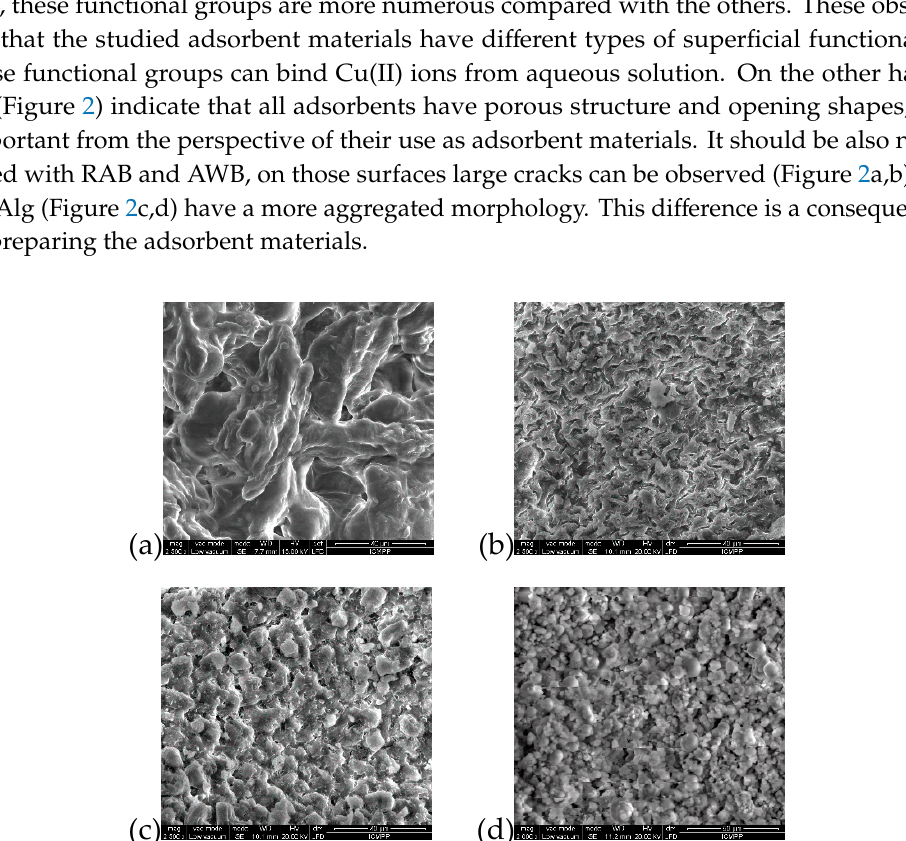
Figure 3. Influence of contact time on Cu(II) adsorption efficiency on considered adsorbent materials (initial pH = 4.4; 2.0 g adsorbent/L, c 0 = 25.41 mg Cu(II)/L, temperature = 25 ° C). As the contact time between the solid and liquid phases of the adsorption system increases, the amount of Cu(II) ions retained on the adsorbent materials increases, in all the cases (Figure 3). This increase is more pronounced in the initial stage and depends on the nature of adsorbent material. In